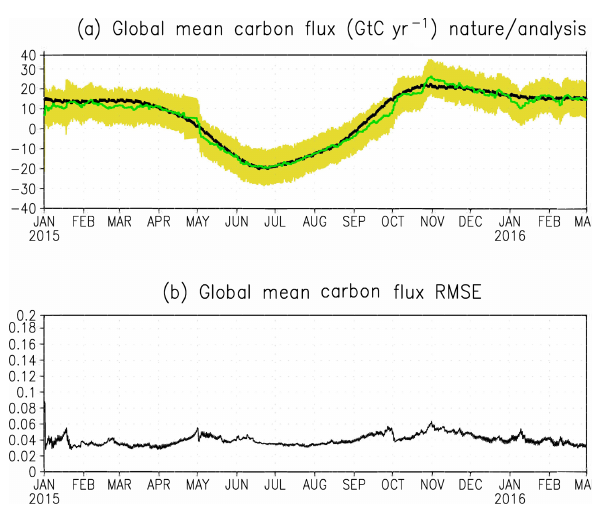
Figure 8. (a) The global total SCF of “truth” and estimation from the benchmark experiment: the black line is the truth, the green line is the ensemble mean of the estimation, and the yellow shading is the ensemble spread. (b) The global mean RMSE of the estimated SCF from the benchmark experiment(AW = 1d, OW = 8d).